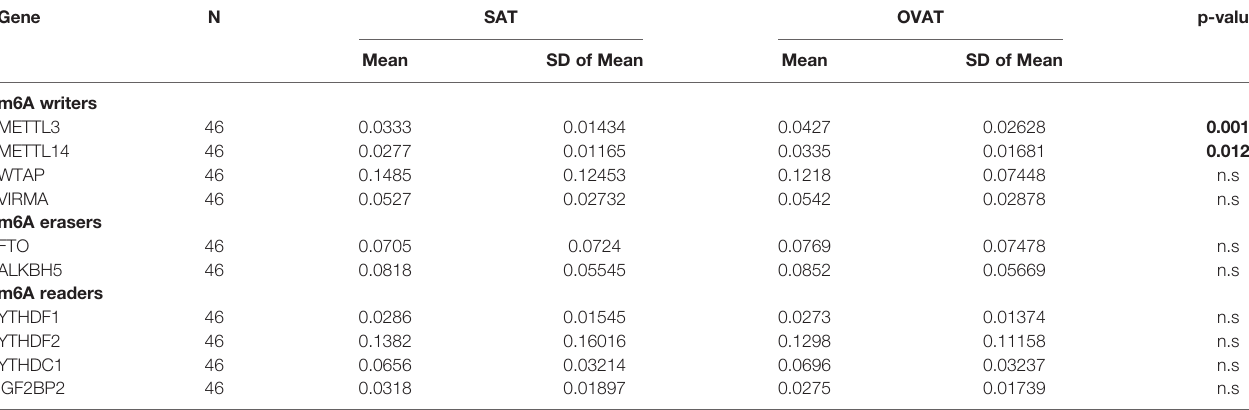
P-values were calculated using Wilcoxon signed rank test for non-normally distributed variables. WHO classi fi cation: lean ≥ 18; <25 kg/m²; overweight ≥ 25; <30 kg/m²; obese ≥ 30 kg/m²; SD, Standard deviation; SAT, Subcutaneous adipose tissue; OVAT, Omental visceral adipose tissue; n.s., not signi fi cant. P-values < 0.05 are highlighted in